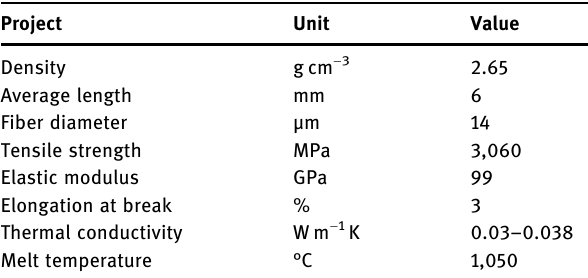
Table 2: Physical and mechanical properties of the basalt fi ber